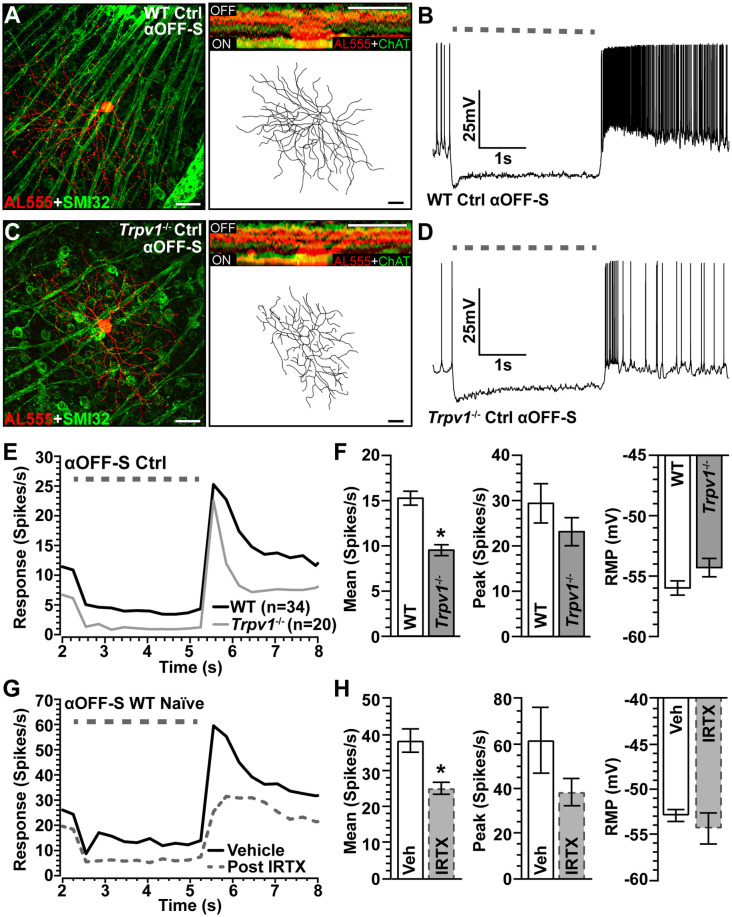
Comparison of WT and Trpv1−/− αOFF-sustained RGCs. (A) WT αOFF-S RGC following intracellular filling (AL555) and labeled for SMI-32 shows dendrites ramifying narrowly in the OFF region of the IPL proximal to ChAT labeling (inset). (B) The voltage response of WT αOFF-S RGC increases and is sustained at the light offset, while excitation diminishes during light stimulation (dashed line). (C)
Trpv1−/− αOFF-S RGC has similar morphology and response to light offset, though less robust than WT (D). When averaged across cells (E,F), the mean response of Trpv1−/− αOFF-S RGCs to light offset was less than WT (9.5 ± 0.6 vs. 15.3 ± 0.8 spikes/s; *p < 0.001), though the RMP was slightly more depolarized (−54.3 ± 0.8 vs. −56.0 ± 0.6 mV; p = 0.07). (G,H) For WT αOFF-S RGCs (n = 5), bath application of IRTX (100 nM) reduced the mean response histogram to light offset (−34%; *p < 0.001), though peak off response and RMP were not affected (p ≥ 0.14). WT control group consists of 10 cells from naïve eyes and 24 cells from saline-injected eyes. (A,C) Scale = 40 μm. Statistics: Mann–Whitney tests (F) and paired t-tests (H). Data = mean ± SEM.